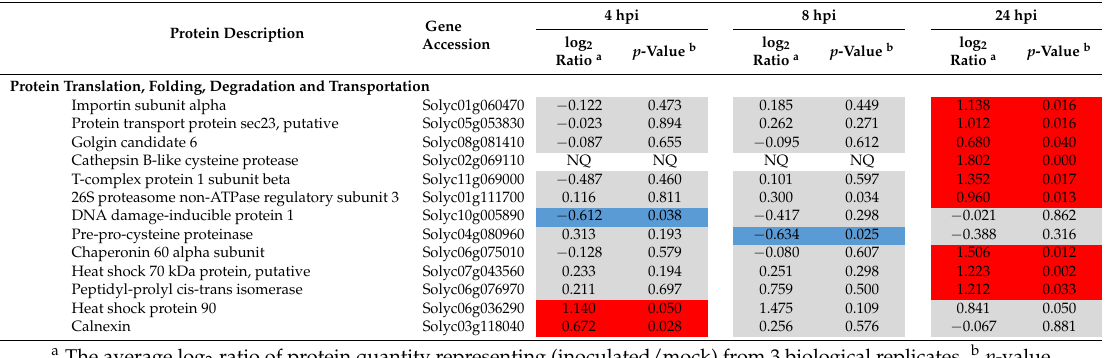
Table 2. Proteins involved in translation, protein folding, degradation and transportation with significant change in abundance at 4, 8, 24, hpi of Pst DC3000.